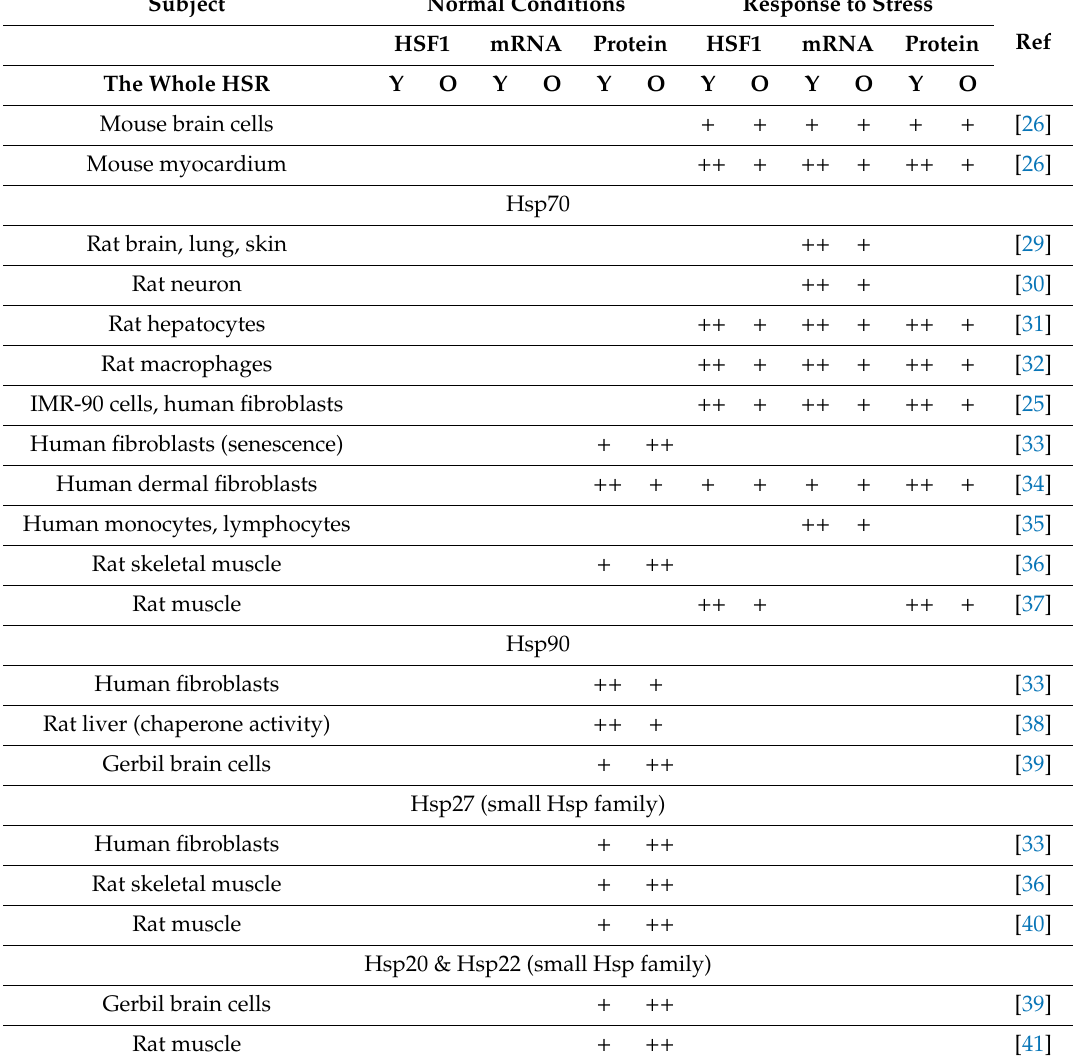
Table 1. Expression of chaperones in aging and stressed